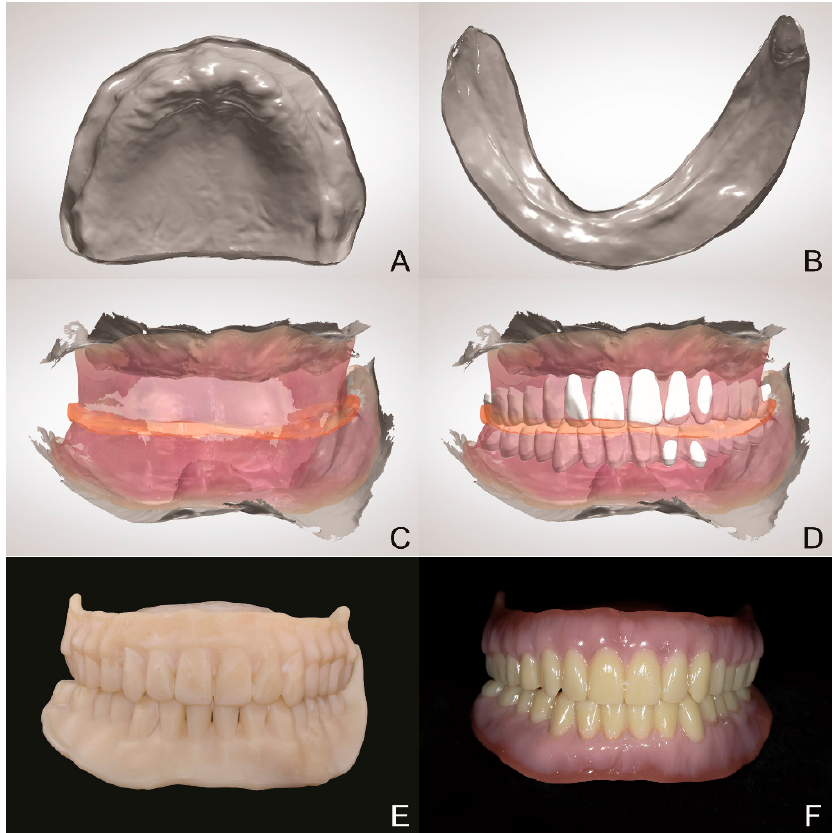
Figure 2. Computer-aided designing and additive manufacturing procedures to fabricate complete dentures. ( A ) Reversed maxillary data derived from the united assembly. ( B ) Reversed mandibular data derived from the united assembly. ( C ) Establishment of the interarch relationship for original standard tessellation language (STL) files. Translucency of the united assembly adjusted to visualize the interarch relationship. ( D ) Artificial tooth arrangement using STL files of the transformed edentulous maxillary and mandibular scan data and the united assembly data. Translucency of the united assembly was adjusted. ( E ) Additively manufactured try-in dentures. ( F ) Finalized digital complete dentures.